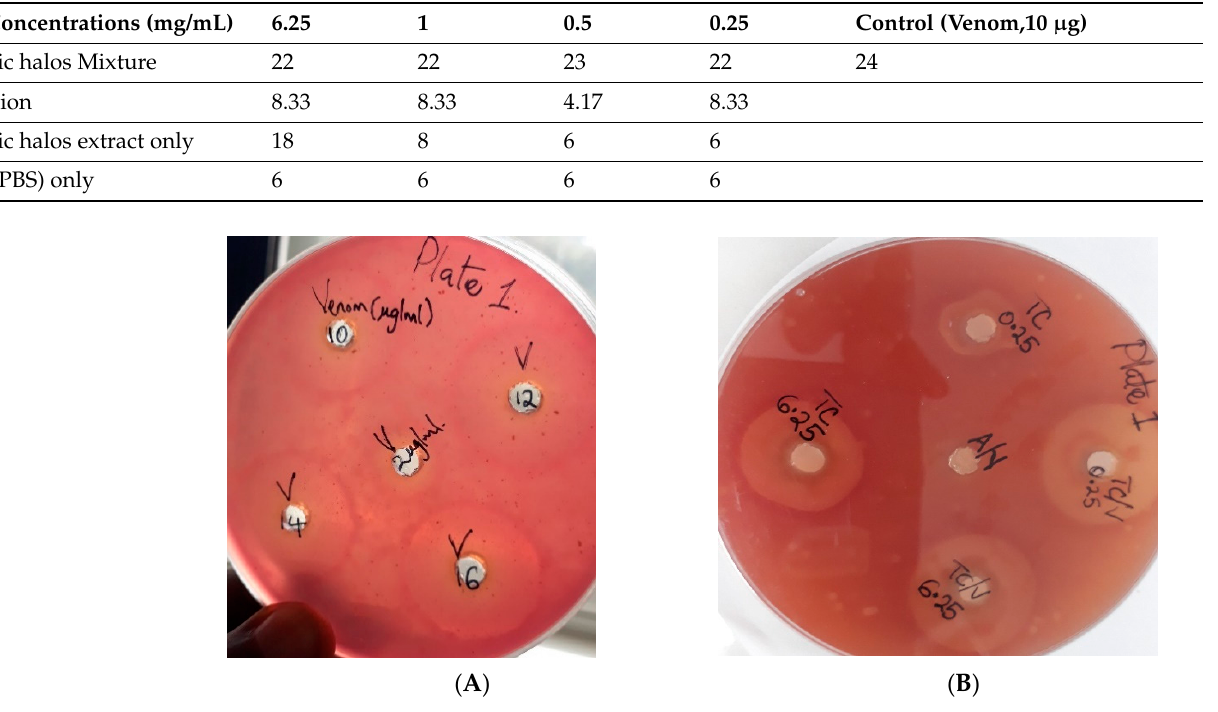
Figure 2. ( A ) Minimum hemolytic dose (MHD), ( B ) Neutralization of PLA 2 hemolytic activities of venom. of